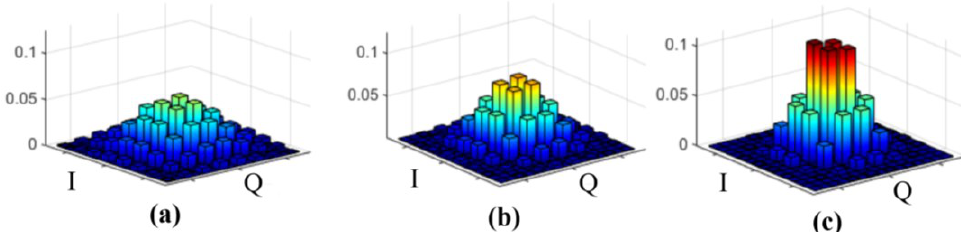
Figure 4. The constellations of the three probability distributions for probabilistically shaped